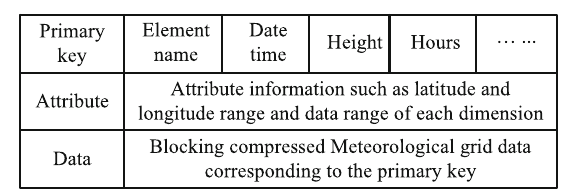
Fig. 3 The storage structure of meteorological grid data